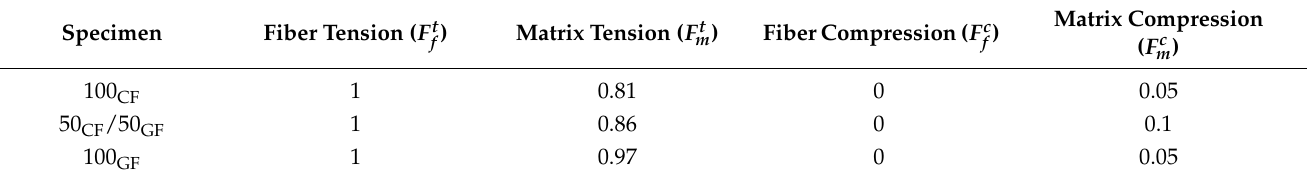
Table 8. Damage predictions for the hybrid and non-hybrid specimens according to the Hashin failure criterion at maximum failure